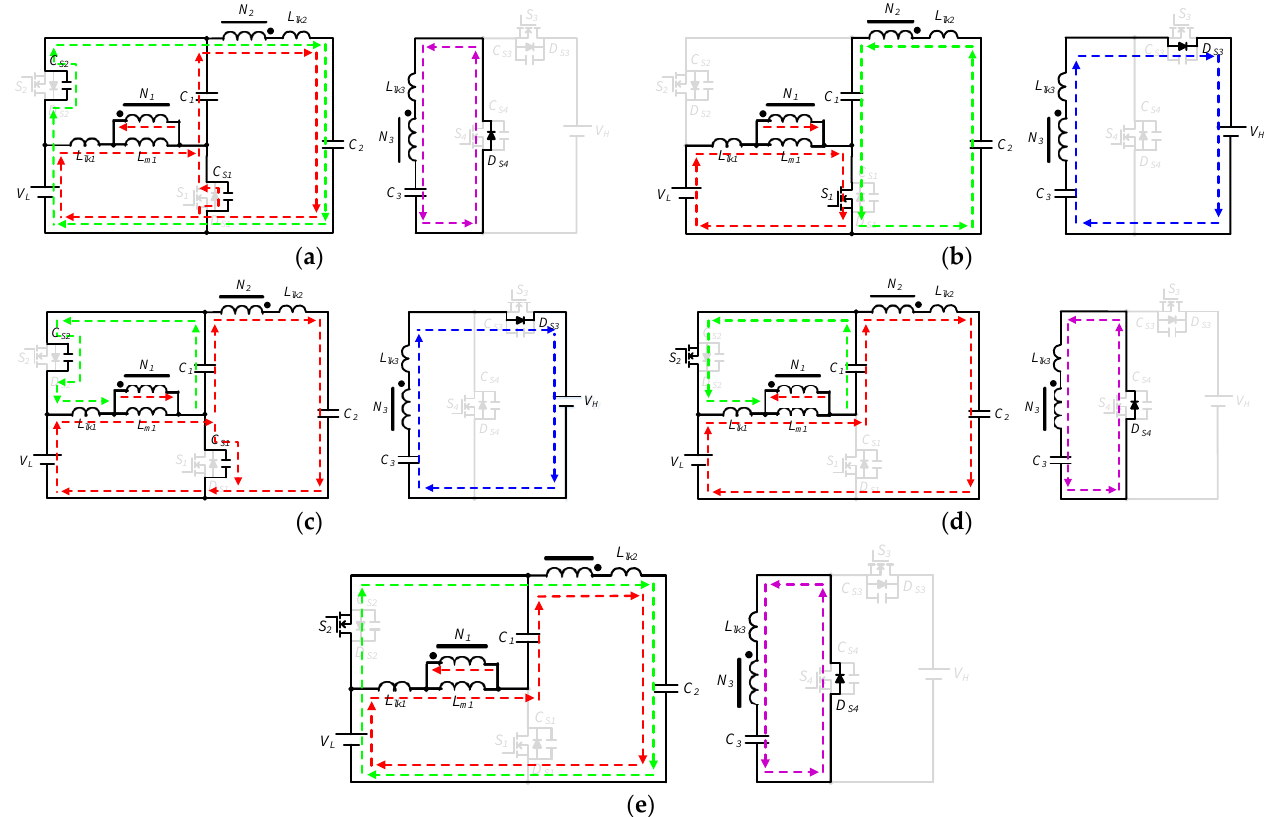
Figure 5. Equivalent circuit diagram of ( a ) mode 1, ( b ) mode 2, ( c ) mode 3, ( d ) mode 4, and ( e ) mode 5 in the step-up mode.